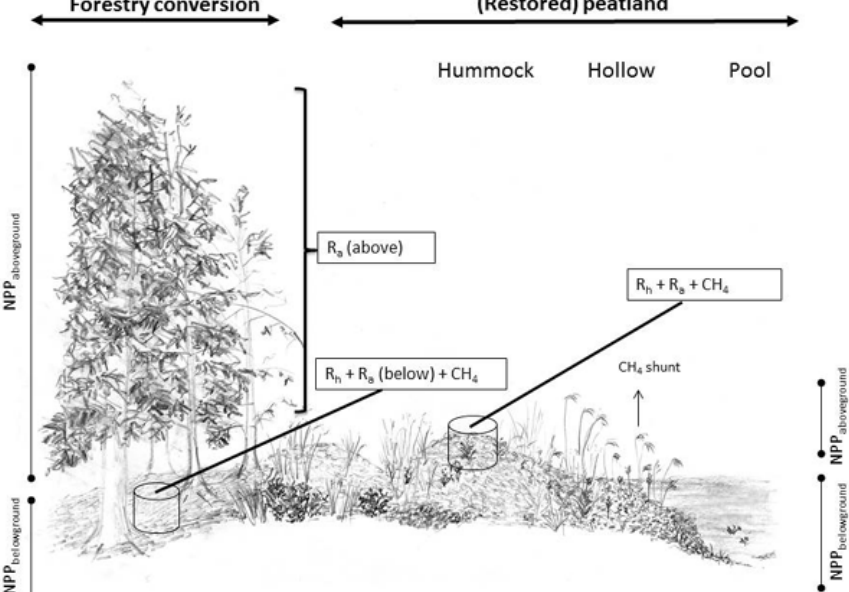
Fig. 1. Simplified drawing of the difference in captured gas fluxes with small chamber-based GHG measurements in forestry (left) or (restored) peatland sites (right). Chamber height, volume and location determine which of the net fluxes are included or excluded in each of the two settings. In the peatland setting, the opaque chamber dimensions of Yamulki et al. (2013) allow for inclusion of both the entire autotrophic and heterotrophic respiration pools ( R a and R h , respectively) and hence represent dark net ecosystem respiration ( R eco-dark ) . Use of clear chambers in such settings can also capture GPP (gross primary productivity) as well as R eco-light . A reasonable estimate of net ecosystem productivity (NEP) could be achieved by using reliable GPP and a modelled R eco measured throughout diurnal and seasonal cycles. Net methane fluxes (CH 4 ) are also included. Ensuring sufficient coverage of peatland microtopography (e.g. hummocks, hollows, and pools) however is required as, for example, aerenchymatous species in hollows may act as CH 4 shunts. In the forest setting, use of the same chambers will include R h but only the below-ground components of R a , as the stems, branches and needles of the tree biomass ( R a ) are not included within the chamber. This means that, for a reasonable estimate of NEP to be established, at the very least the aboveground component of R a would require to be measured, along with GPP. Often, however, GPP is not directly measured in forest ecosystems and instead some components of NPP are measured by stock assessments of aboveground biomass, e.g. stem, branch and needle biomass, coupled with estimates of below-ground NPP. In addition, in forest stands, the chambers will include net CH 4 fluxes. The other components of NECB, for example the net exported fluxes of aqueous carbon such as DOC and POC are often also substantial and some, such as oxidised carbon export through fires or off site biomass combustion/decay, are rarely investigated (see main